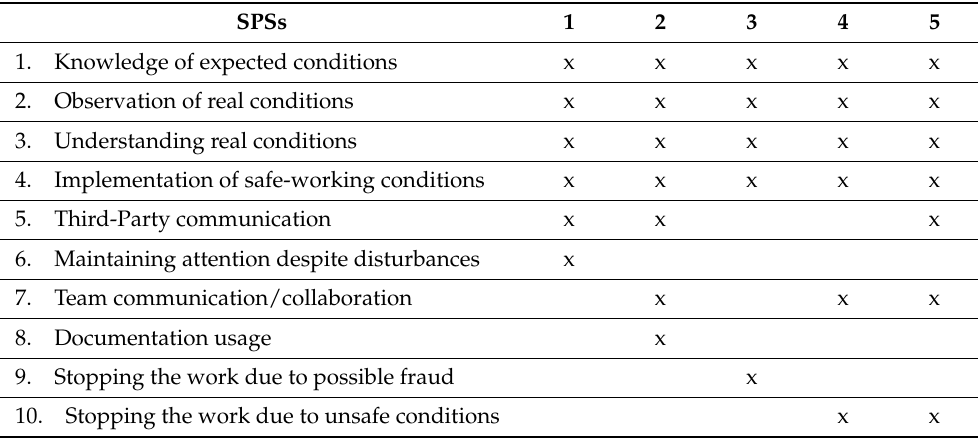
Table 1. The matching between scenarios, the SPS and the specific behavioral markers. SPSs